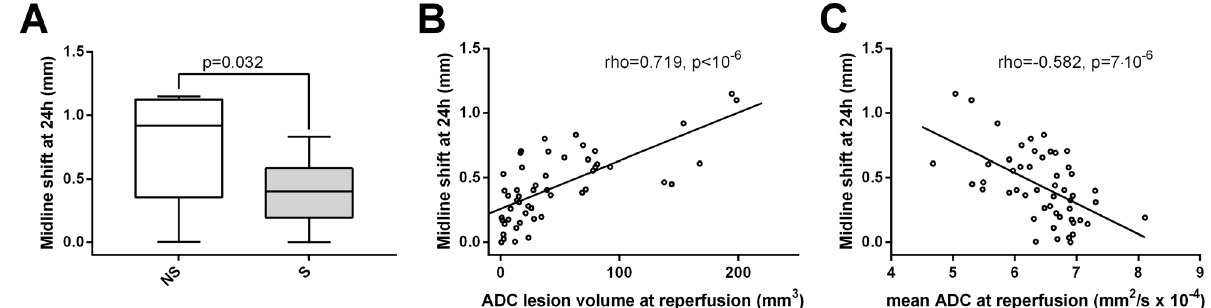
Figure 4. Cerebral midline-shift (assessed 24 h post injury) is increased in rats not surviving ischemia– reperfusion injury, which correlates with lesion volumes calculated by apparent diffusion coefficient (ADC) maps at reperfusion. ( A ) Summary data of differences between survival (S) and non-survival (NS) rats (n = 46, n = 5 respectively) in midline-shift (mm) measured 24 h post-reperfusion. Whiskers are set at minimum and maximum, the horizontal line marks the median, whereas box indicates the interquartile range (25–75%). 2-sided exact p-value is based on Mann–Whitney U-test. ( B ) Correlation between ADC lesion volume (mm 3 ) at reperfusion and midline-shift (mm) measured 24 h post-reperfusion in the studied rats (n = 51). rho = Spearman’s rank correlation coefficient. ( C ) Correlation between mean ADC of the initial lesion site at reperfusion (mm 2 /s × 10 –4 ) and midline-shift (mm) measured 24 h post-perfusion in the studied animals (n = 51). rho = Spearman’s rank correlation coefficient. sion was not associated with MLS (Spearman’s rho = 0.135, 2-sided p = 0.345). At reperfusion, mean ADC of the initial lesion site was negatively correlated with MLS (Spearman’s rho = − 0.582, 2-sided p = 7 × 10 –6 , Fig. 4C), while during occlusion, there was a positive association between them (Spearman’s rho = 0.390, p = 0.005). Neurological scores. Day 1 general, focal and total neurological deficit scores were significantly higher in the non-survival group (2-sided exact, p = 0.0014, p = 0.0110 and p = 0.0004, respectively; Fig. 5A). Day 1 general, focal and total neurological deficit scores were positively correlated with lesion volume at reperfusion (2-sided p = 0.0025, p < 0.0001 and p < 0.0001, respectively, Fig. 5B) and negatively correlated with mean ADC of the ini- tial lesion site at reperfusion (2-sided p = 0.0190, p = 0.0018 and p = 0.0057, respectively, Fig. 5C). The diffusion measures during occlusion were not related to day 1 neurological scores as demonstrated by non-significant Spearman’s correlations between lesion volume during occlusion and Day 1 general, focal and total neurologi- cal deficit scores (2-sided p = 0.692, p = 0.238, p = 0.455, respectively) and non-significant correlations between mean ADC of the initial lesion site during occlusion and Day 1 general, focal and total neurological deficit scores (2-sided p = 0.739, p = 0.078 and p = 0.178, respectively). The same correlation pattern was observed for day 2–4 neurological scores, while neurological scores from later timepoints (day 7 onwards) showed no significant association with diffusion measures at reperfusion either.